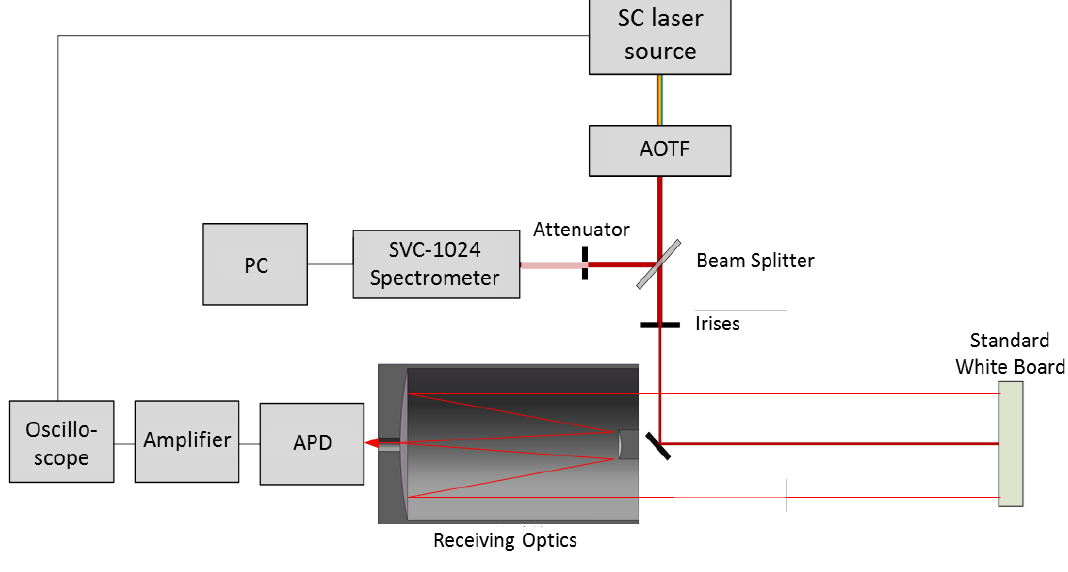
Figure 2. Calibration of AOTF-HSL.